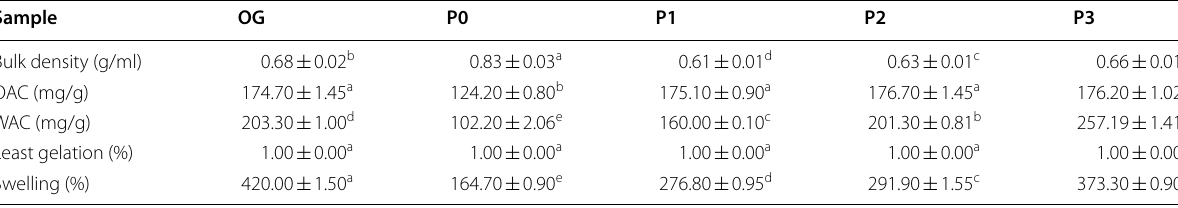
Values are mean of three determinations standard deviation ( n 3). Values with the different superscript within the same row are significantly different from each ± = other ( p 0.05) ≤ Keys: P0 Full fat milk 30%, peanut 25%, soybean oil 15%, sugar 28%, mineral mix 2%, P1 Orange-fleshed sweet potato 26.5%, sorghum 26.5%, full fat milk 30%, = = soybean oil 5%, sugar 10%, moringa leaves 2%); P2 Soycake 15%, Orange fleshed sweet potato 26.5%, sorghum 26.5%, full fat milk 15%, soybean oil 5%, sugar 10%, = moringa leaves 2%;